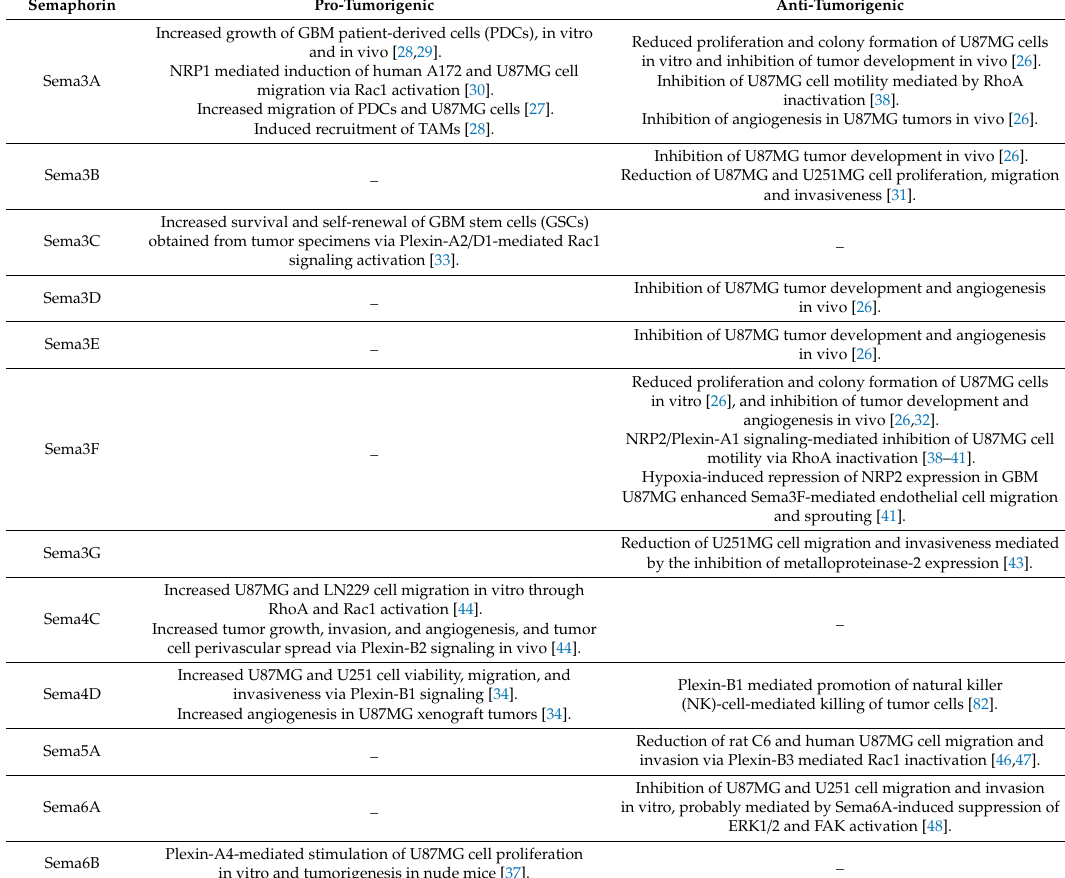
Table 1. Current knowledge about the function of diverse semaphorins in